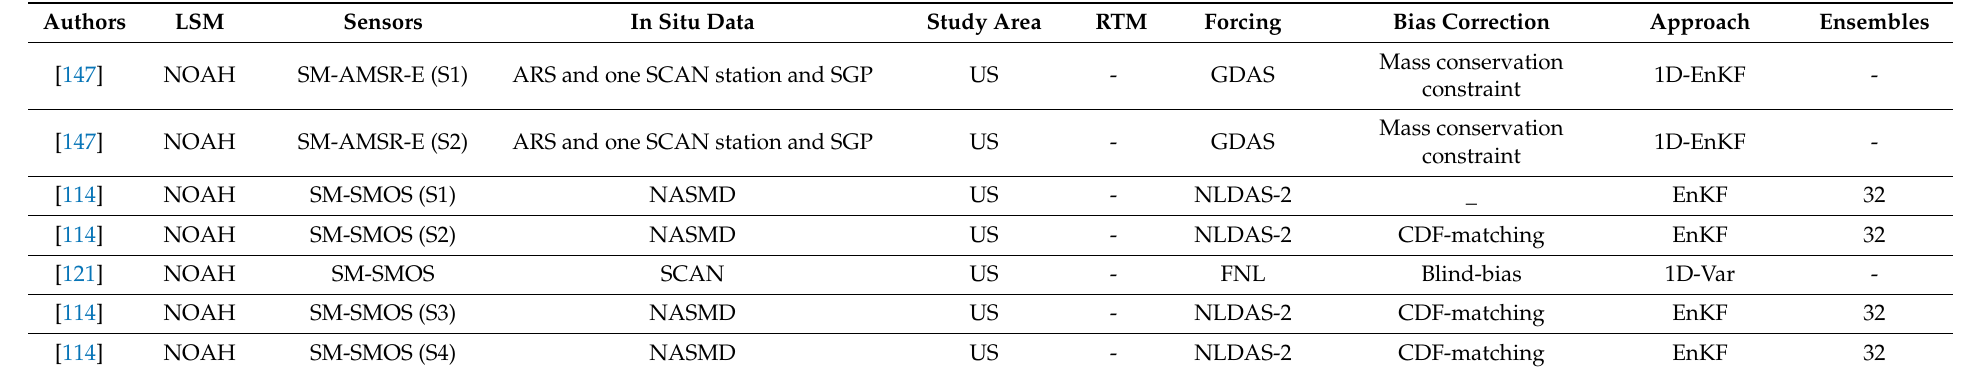
Table 8. RSM Bias improvements of more than − 0.07 (m3 m-3) for papers reviewed in this